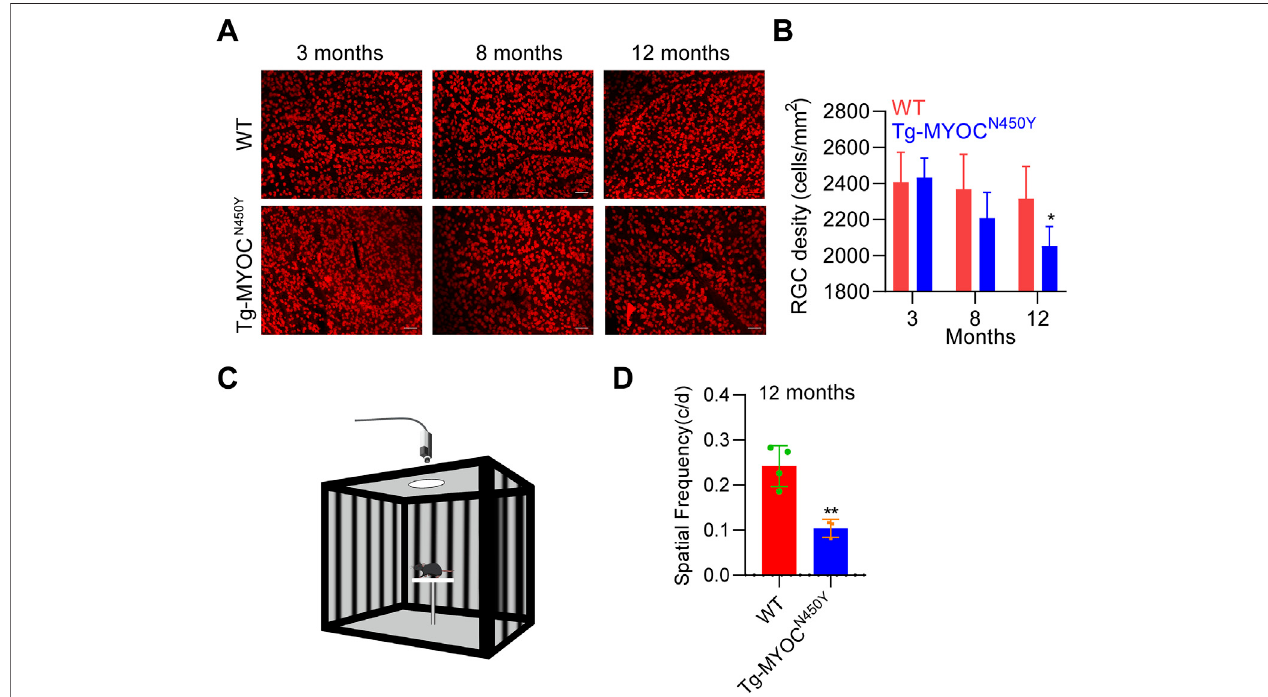
FIGURE6| MutantMYOCleadstoRGClossandvisualimpairment (A) WholemountretinalpreparationswerestainedwithRBPMSantibodyinWTlittermatesand Tg-MYOC N450Y mice at 3, 8 and 12 months of age. (B) Average RGC numbers of (A) were quanti fi ed using ImageJ software. *, p < 0.05. (C) Diagram of virtual optokinetic system. (D) The virtual optokinetic system was applied to evaluate the maximum spatial frequency in WT littermates and Tg-MYOC N450Y mice at age of 12 months. **, p < 0.01.